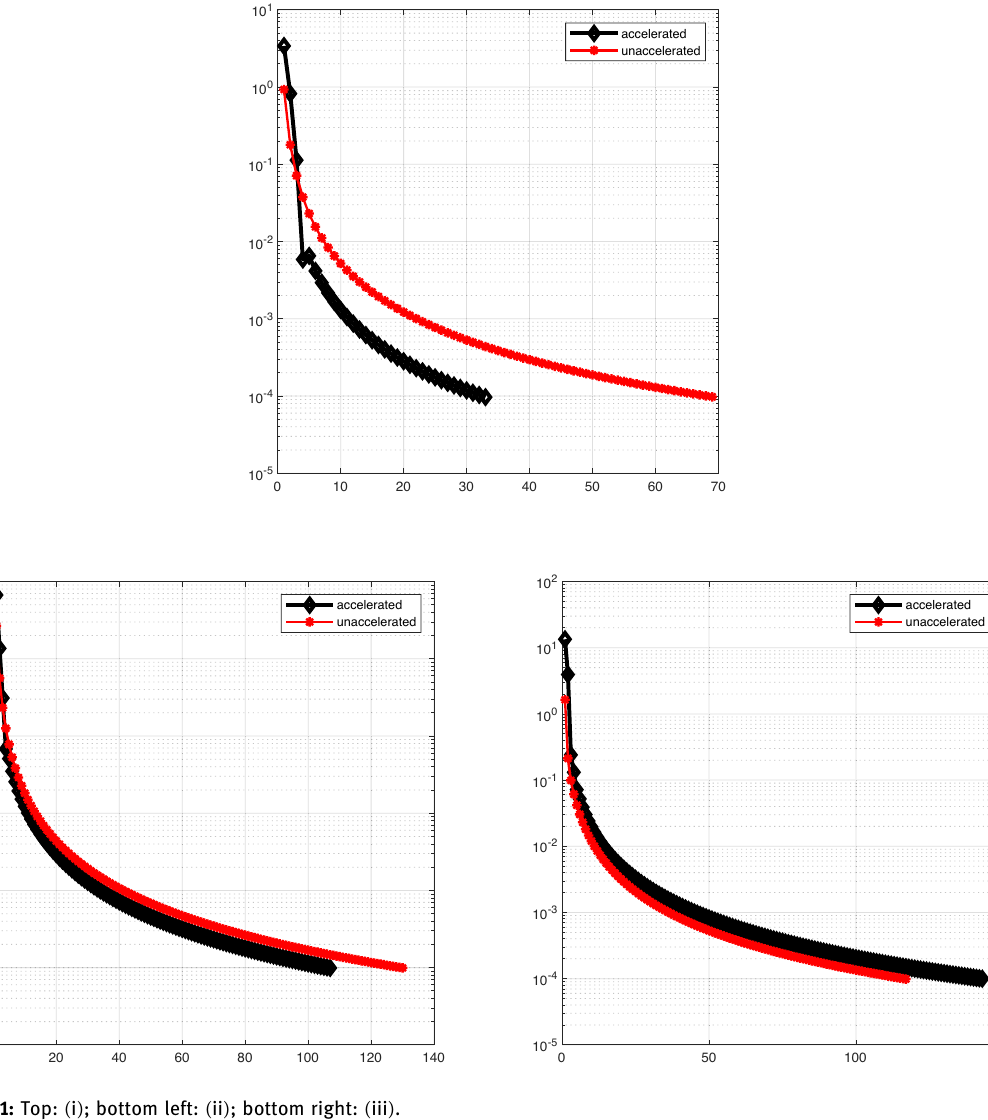
Figure 1: Top: ( i ) ; bottom left: ( ii ) ; bottom right: ( iii )